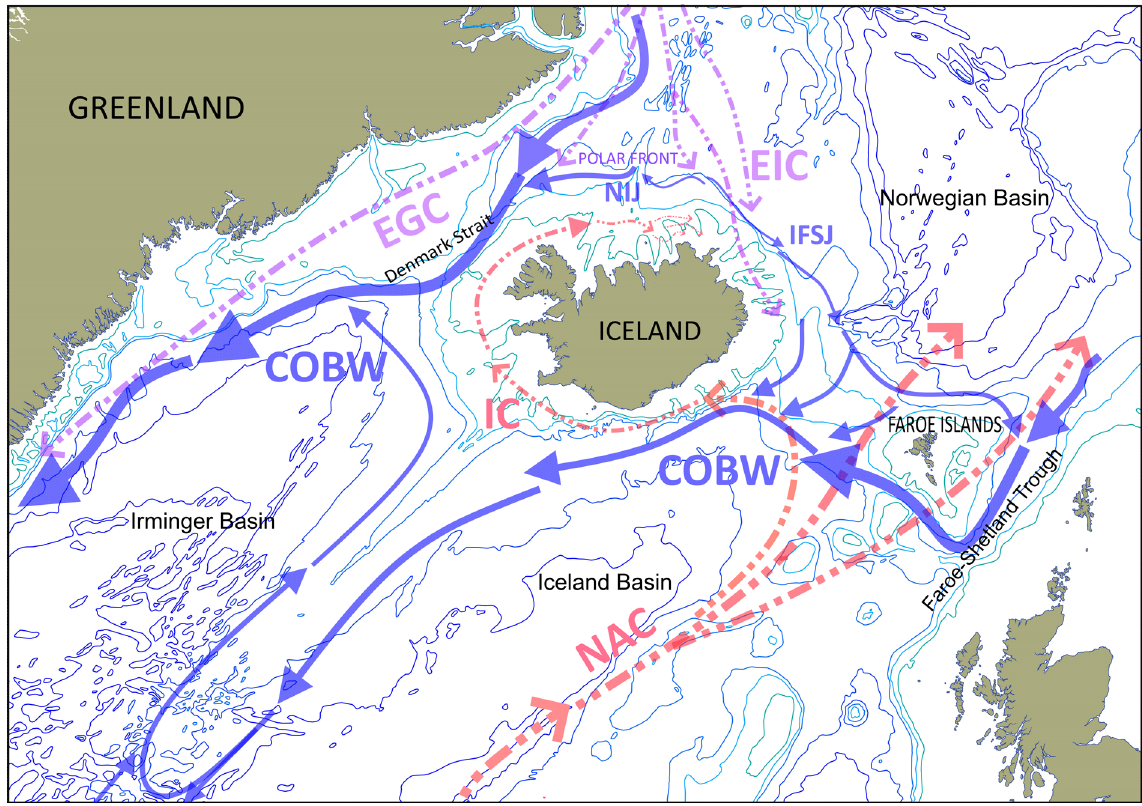
Fig. 23. Simplified scheme of the main sea currents that affect bottom water temperature in the vicinity of Iceland. Surface currents affecting the continental shelf and slopes are symbolized as dotted lines: the cold East Icelandic Current (EIC) and the cold East Greenland Current (EGC), jointly form the Polar Front north off Iceland; the warmer Irminger Current (IC), is a branch of the North Atlantic Current (NAC). Unbroken blue lines, affecting deeper bottom waters (> 500 m): the Cold Overflow Bottom Water currents (COBW), the North Icelandic Jet (NIJ) and the Icelandic-Faroe Slope Jet (IFSJ) (compiled after Valdimarsson et al . 2012; Logemann et al . 2013; Jochumsen et al . 2017; Semper et al . 2019; Símonarson et al .